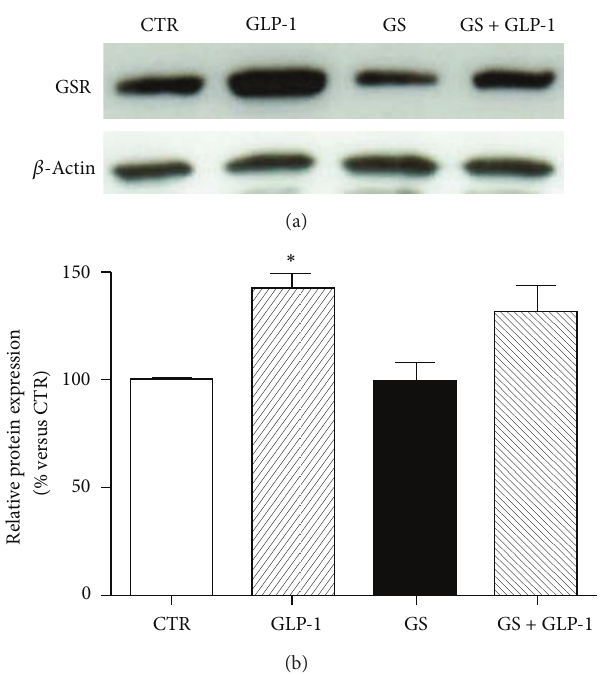
Figure 4: GLP-1 increases MafA protein expression levels in HIT-T15 cells cultured in the presence of GS. (a) Representative western blot of three different experiments. (b) Quantification of densitometries of western blot bands. Data were expressed as mean ± SE of fold induction relative to 𝛽 -actin ( 𝑛 = 3 ). ∗ 𝑃 < 0.05 versus CTR; § 𝑃 < 0.05 versus